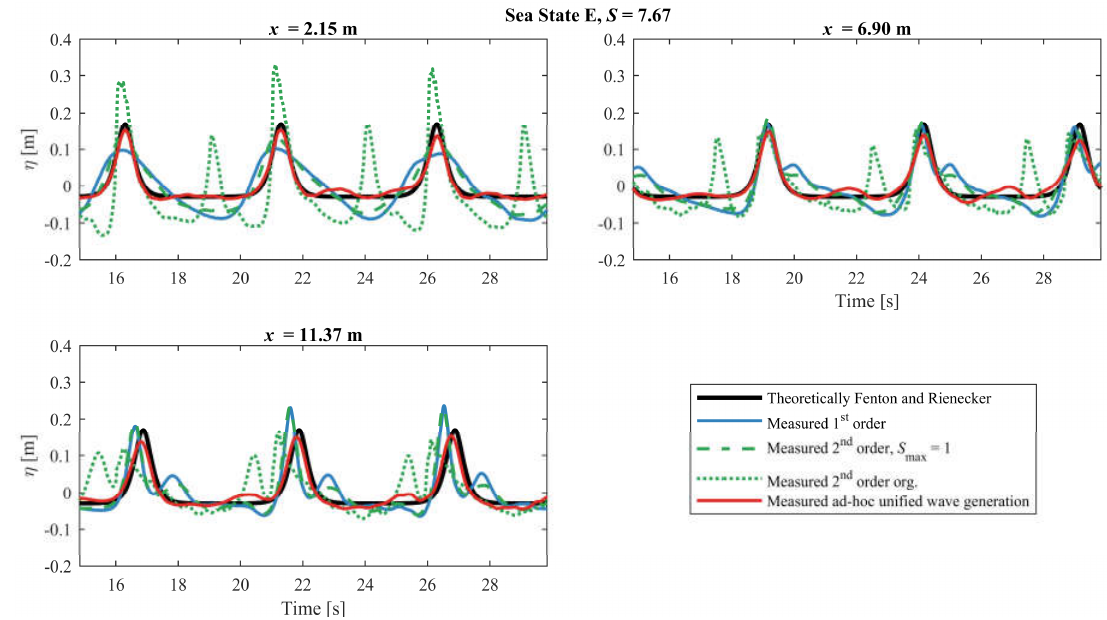
Figure 9. Theoretically surface elevation compared with the first-order, second-order, modified second-order and the ad-hoc unified wavemaker method for Sea State E.